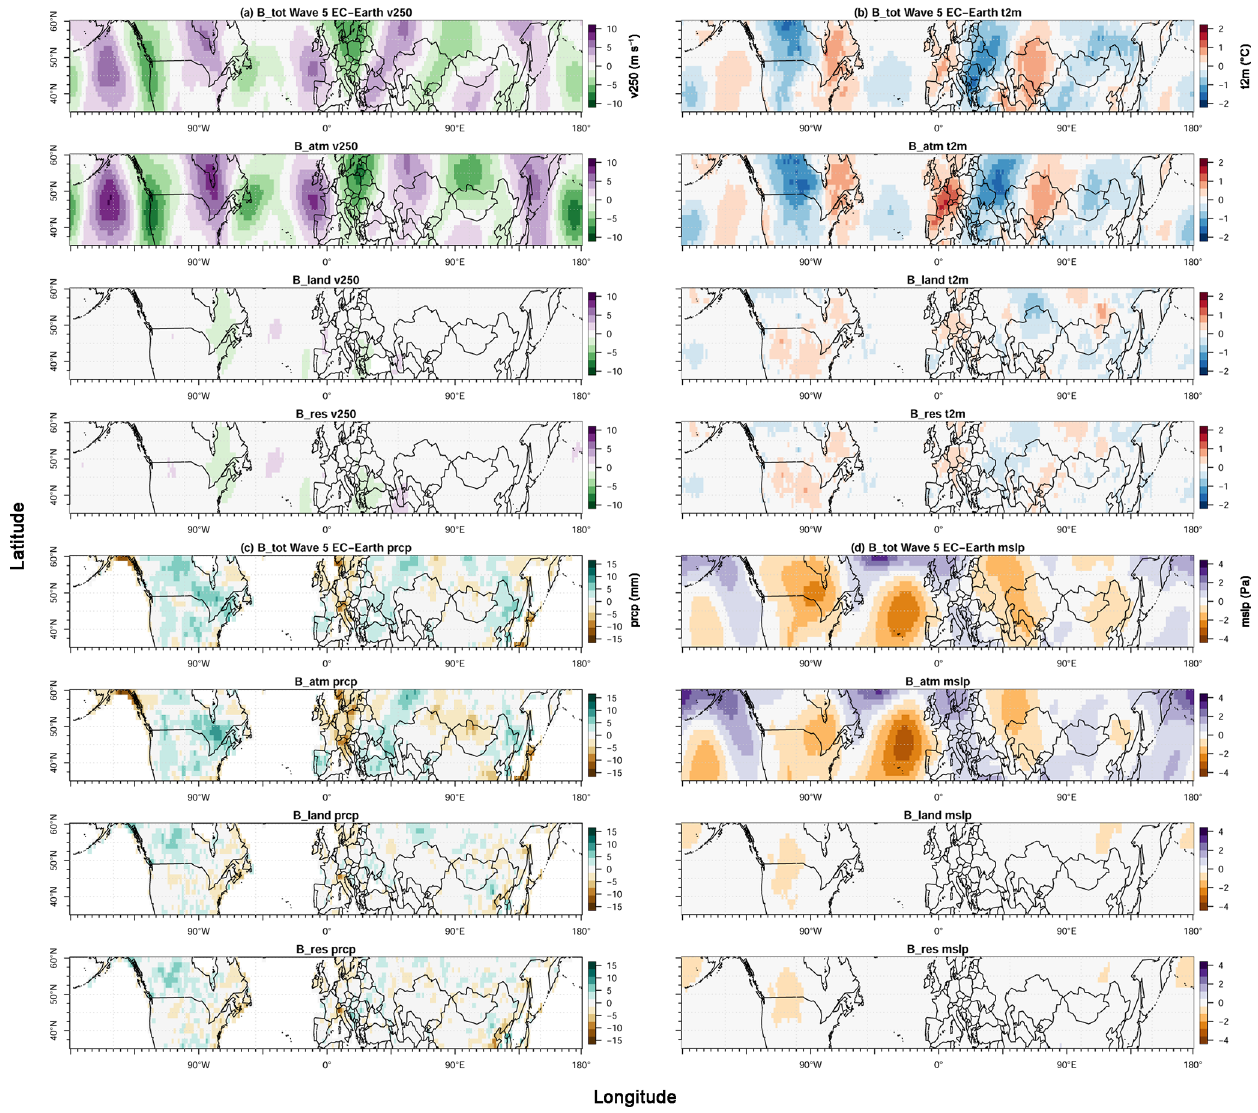
Figure 7. Bias plots for high-amplitude wave-5 events and episodes in different experiments for EC-Earth. Total bias (B_tot), atmospheric bias (B_atm), land–atmosphere interaction bias (B_land), and residual bias (B_res) for meridional wind velocity at 250hPa (a) , surface temperature (b) , precipitation (c) , and sea level pressure (d)